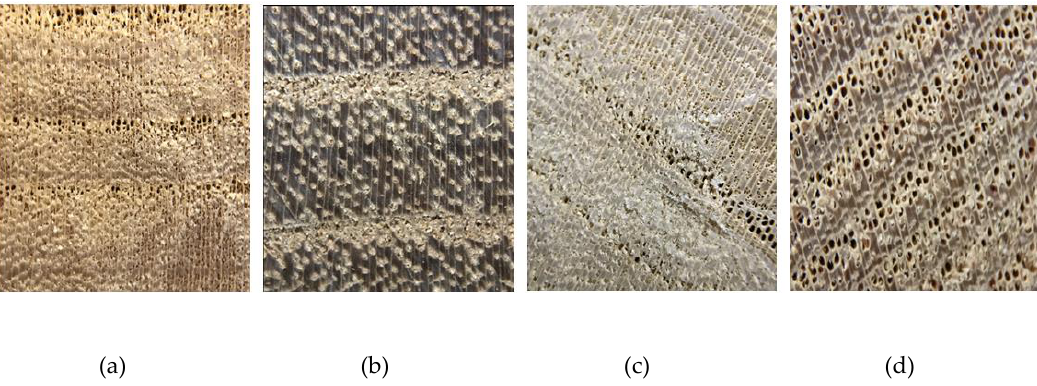
Figure 1. Examples of cross sections of American elm ( a ), black locust ( b ), hackberry ( c ), and honey locust ( d ), were used as the dataset for the machine-learning model.